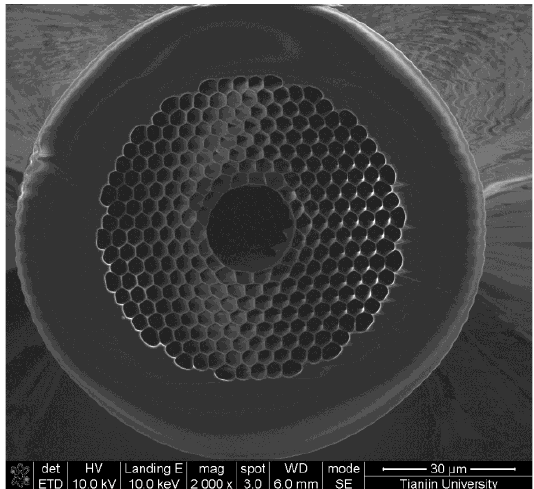
Figure 2. The cross-section of the HC-PCF.